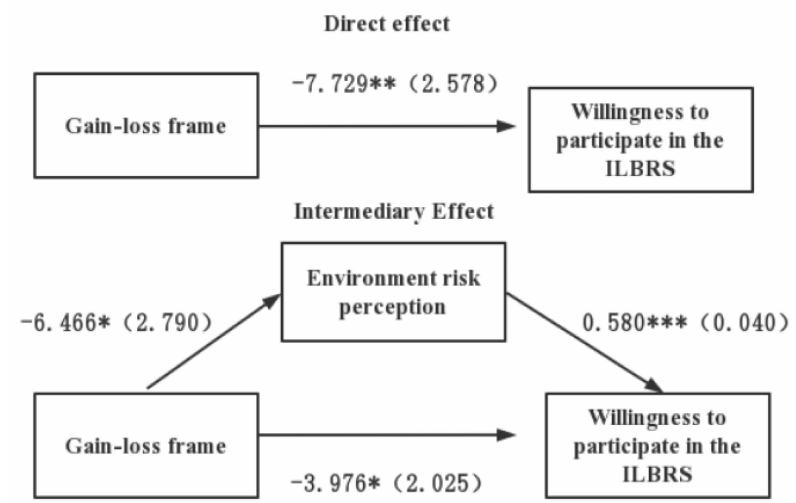
Figure 1. Path diagram of the analysis of the perception of environmental risk on the gain and loss frame on the mediation of the ILBRS participation intention. Note: gain-loss frame: 0 = loss frame, 1 = gain frame; *** p < 0.001, ** p < 0.01, * p <